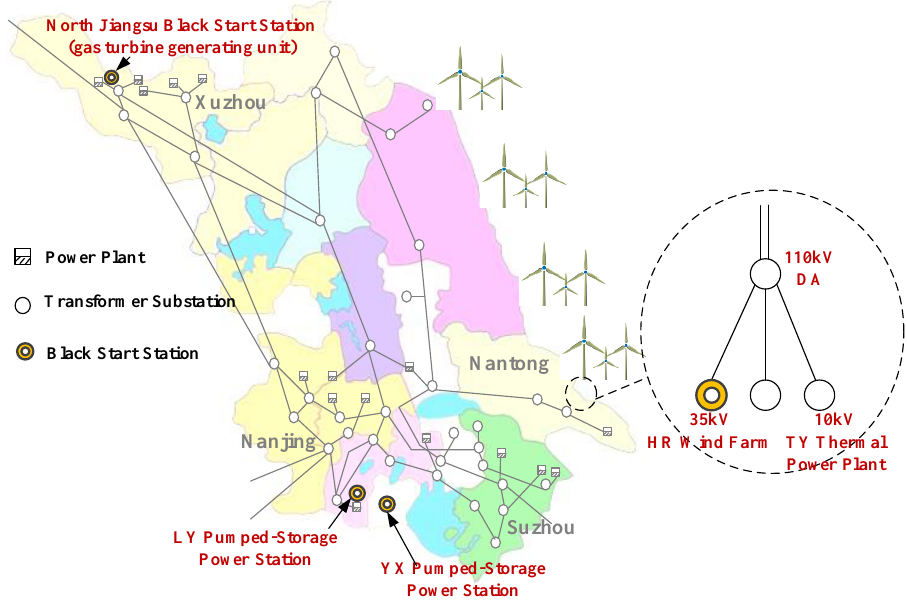
Figure 1. 500-kV power grid of Jiangsu Province, China and the three existing black start stations.